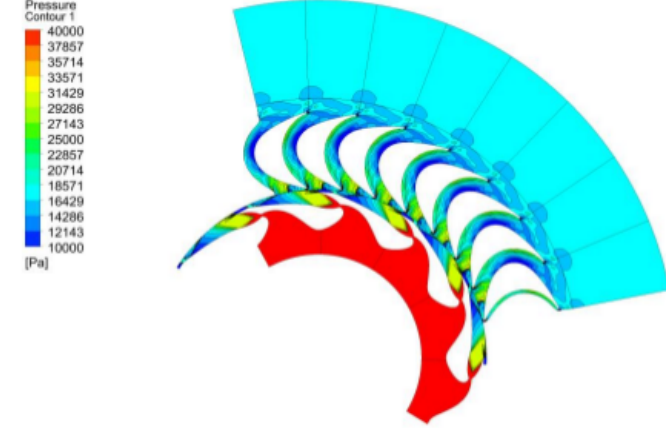
Figure 6: The distribution of the static pressure at 50% of the